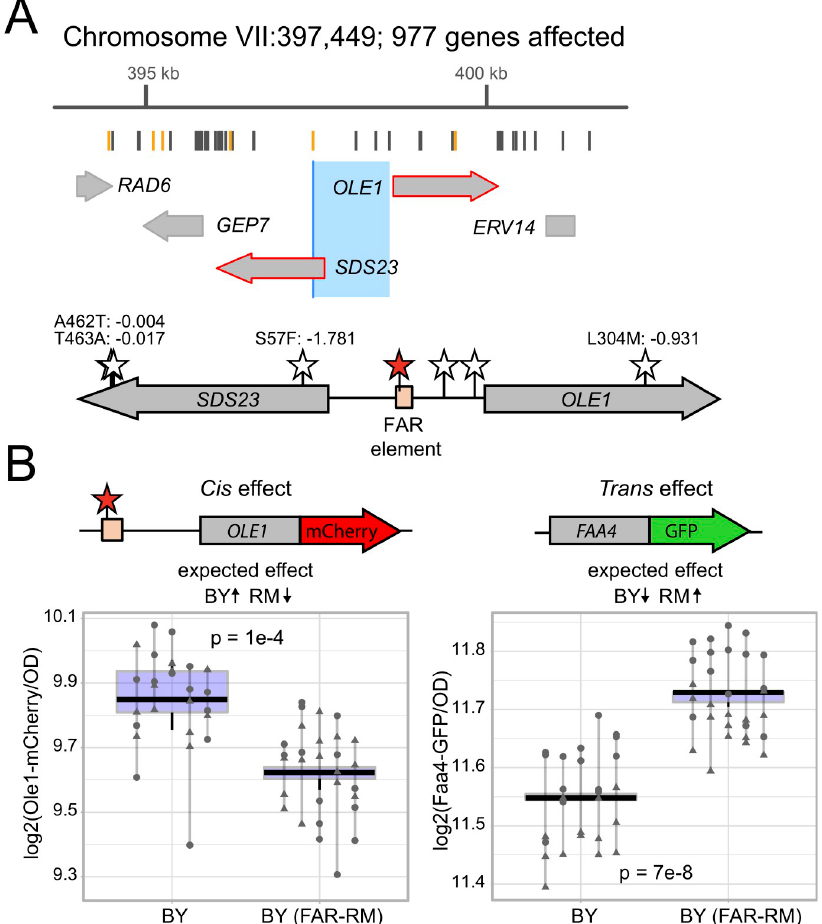
Fig 5. The OLE1 causal variant. A. Schematic of the eQTL hotspot on Chromosome VII. From top to bottom, the figure shows the hotspot location on the chromosome and the number of genes it affects, the positions of the BY and RM sequence variants (gray lines mark synonymous and intergenic variants and orange lines mark missense variants), the genes and their positions in the hotspot (large gray arrows; red outlines denote genes with a local eQTL) The 95% confidence interval (medium blue) and the position of markers perfectly linked to the hotspot peak marker (dark blue). For this locus, the 95% and 90% confidence intervals were identical. Modified from Supplementary File 5 in [12]. B. Schematic of the SDS23 / OLE1 region. BY / RM variants in the intergenic region and missense variants in the genes are indicated by stars, with the identified causal variant in the FAR element (peach box) in red. The missense variant amino acid positions, their resulting amino acid change and their PROVEAN scores [53] are shown. The synonymous variants are not depicted. C. Fluorescence levels of Ole1-mCherry (left panel) and Faa4-GFP (right panel). The BY strains harbor both Ole1-mCherry and Faa4-GFP and the indicated OLE1 alleles. The direction of the expected effects on Ole1-mCherry and Faa4-GFP from [12] are shown. Lines group measurements of the same clone. Different symbols (circles, squares, etc.) denote different plate reader